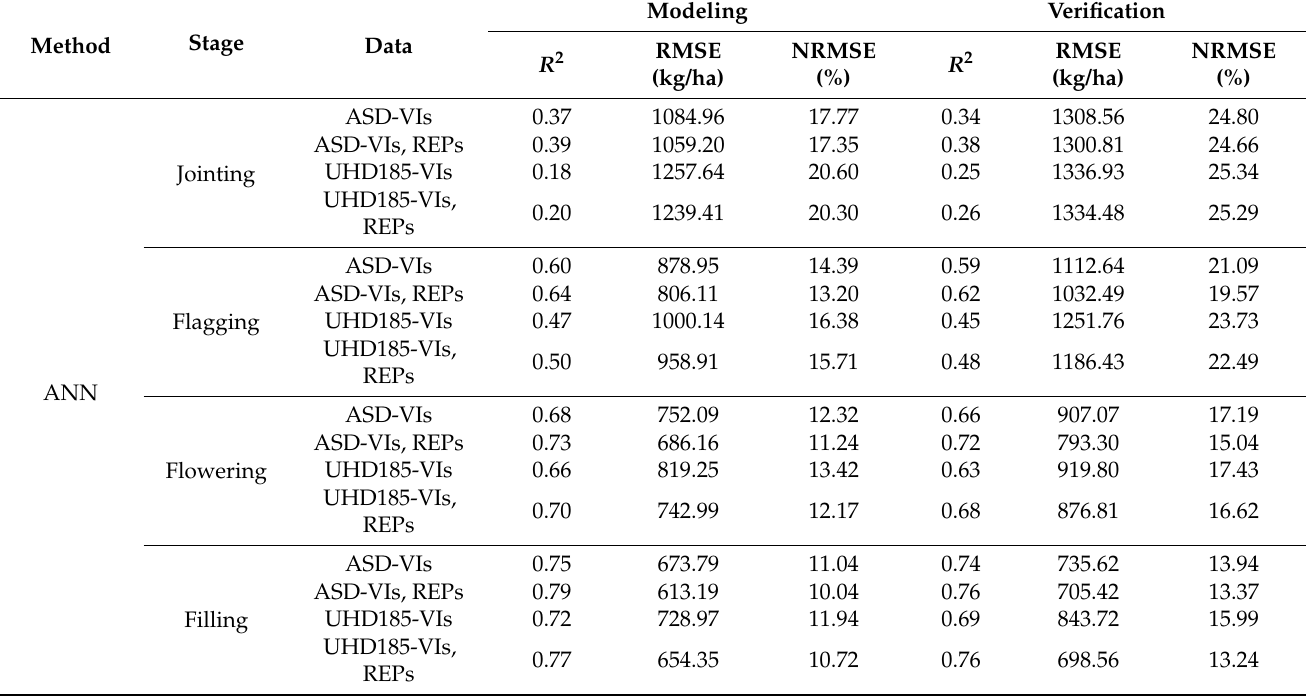
Table 7. Results of the yield estimation based on near-surface hyperspectral data and UAV hyper- spectral data using an artificial neural network